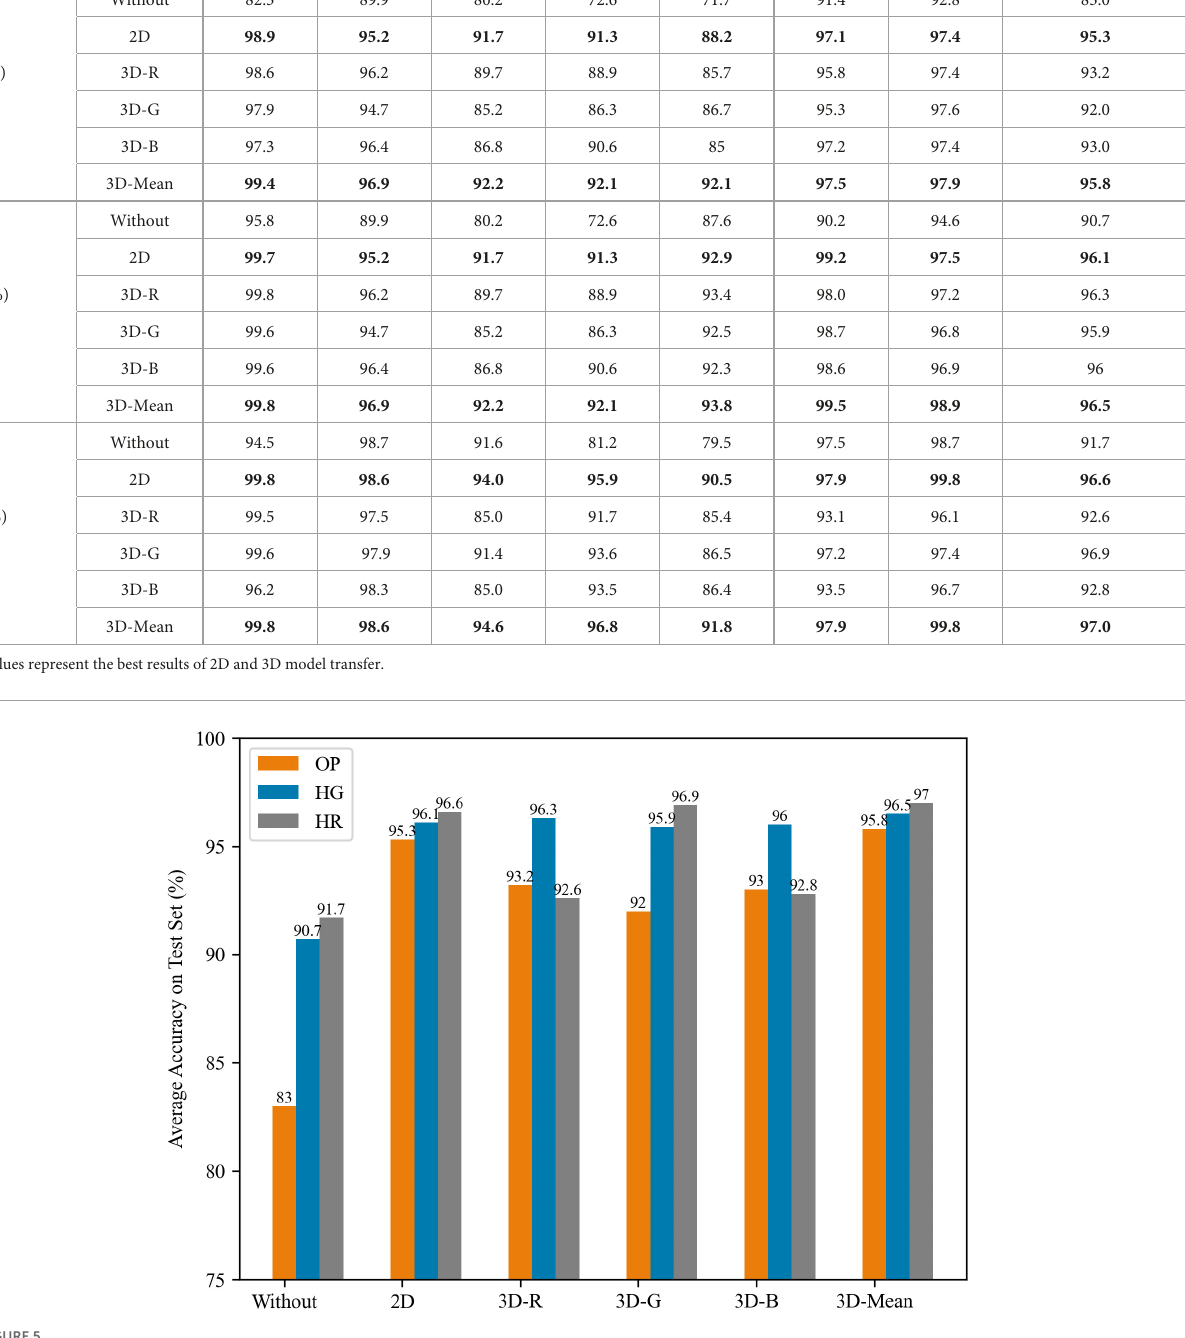
TABLE 1 The average accuracy of different key points. Network